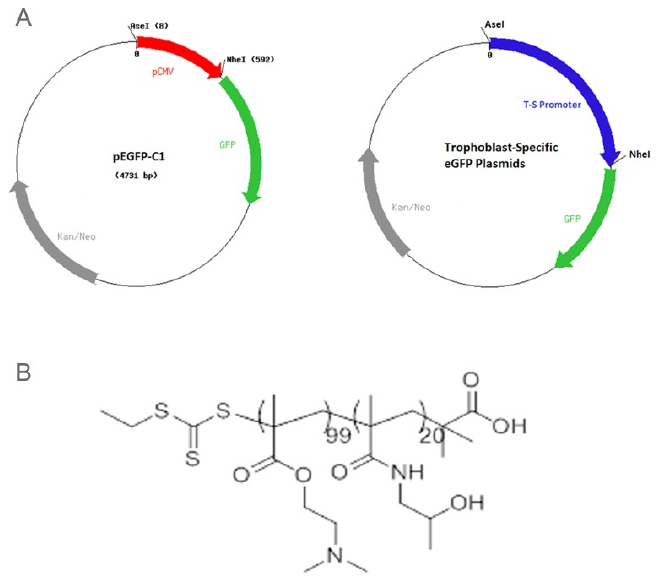
Figure 2. ( A ) Maps of the CMV-eGFP and trophoblast-specific plasmids and ( B ) the HPMA- DMAEMA copolymer used for DNA delivery in vitro and in vivo . Reproduced with permission from [62].